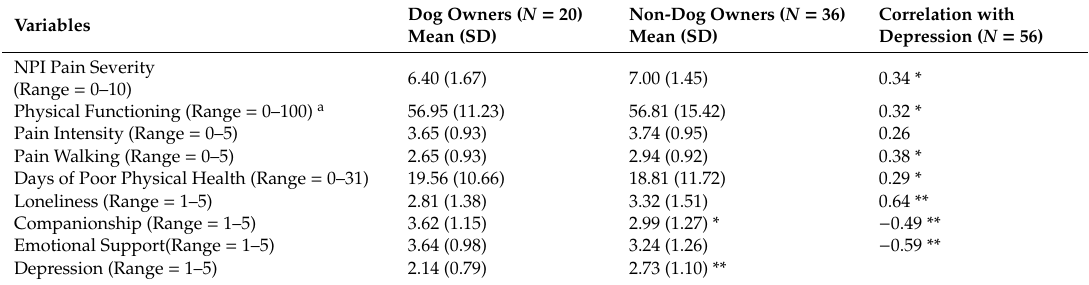
Table 3. Comparison of Dog Owners ( N = 20) versus Non-Dog Owners ( N = 36) and Zero-Order Correlations with